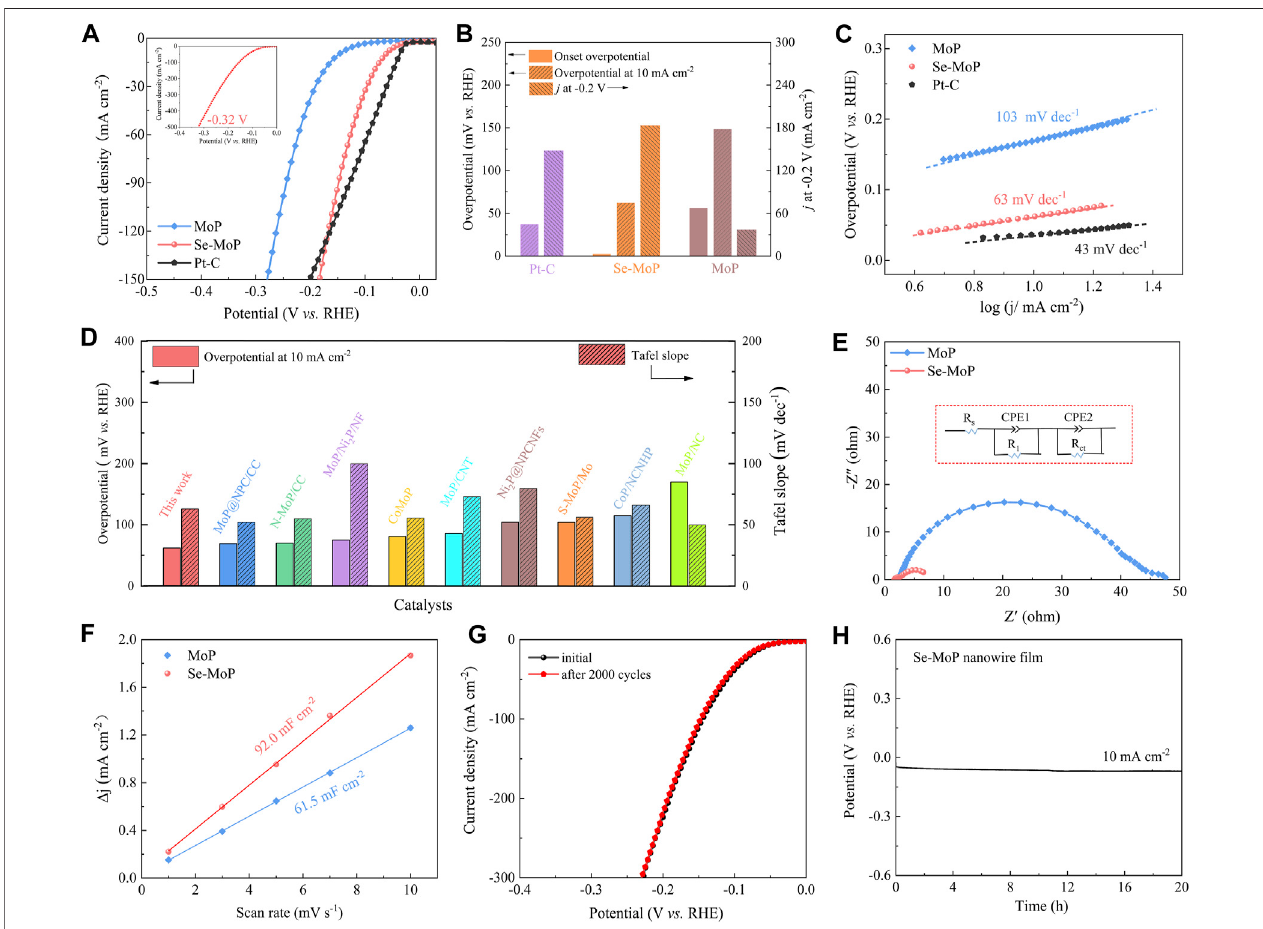
FIGURE 3 | Electrochemical investigations of Se-MoP nanowires, MoP nanowires and commercial Pt/C electrocatalysts in 1 M KOH solution. (A) LSV curves. (B) Comparison of various catalysts in onset potential, overpotential at 10 mA cm − 2 and current densities at − 0.2 V vs . RHE. (C) The corresponding Tafel plots of various catalysts. (D) Comparison of the overpotential and Tafel slope among the Se-MoP nanowires and reported transition metal phosphate-based electrocatalysts under alkaline conditions. (E) Nyquist plots ( − 0.1 V vs . RHE) of MoP and Se-MoP nanowires in 1 M KOH. (F) Double-layer capacitances. (G) LSV curves of Se-MoP nanowires before and after 2,000 cyclic voltammetry cycles. (H) Chronopotentiometric measurement of Se-MoP nanowires at 10 mA cm − 2 .